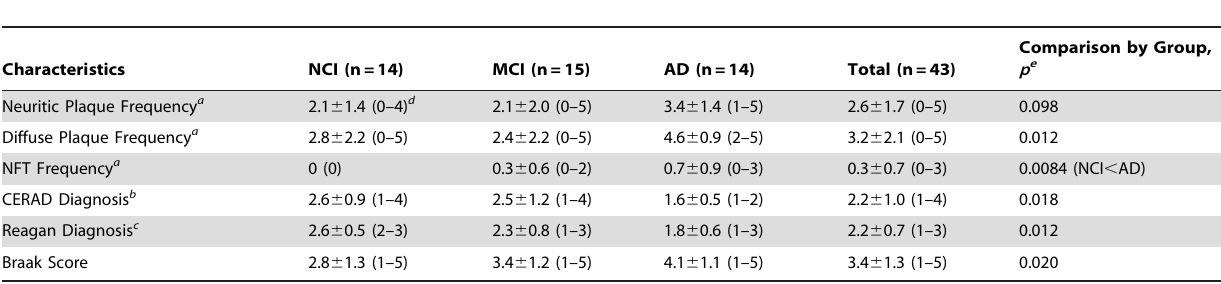
Characteristics